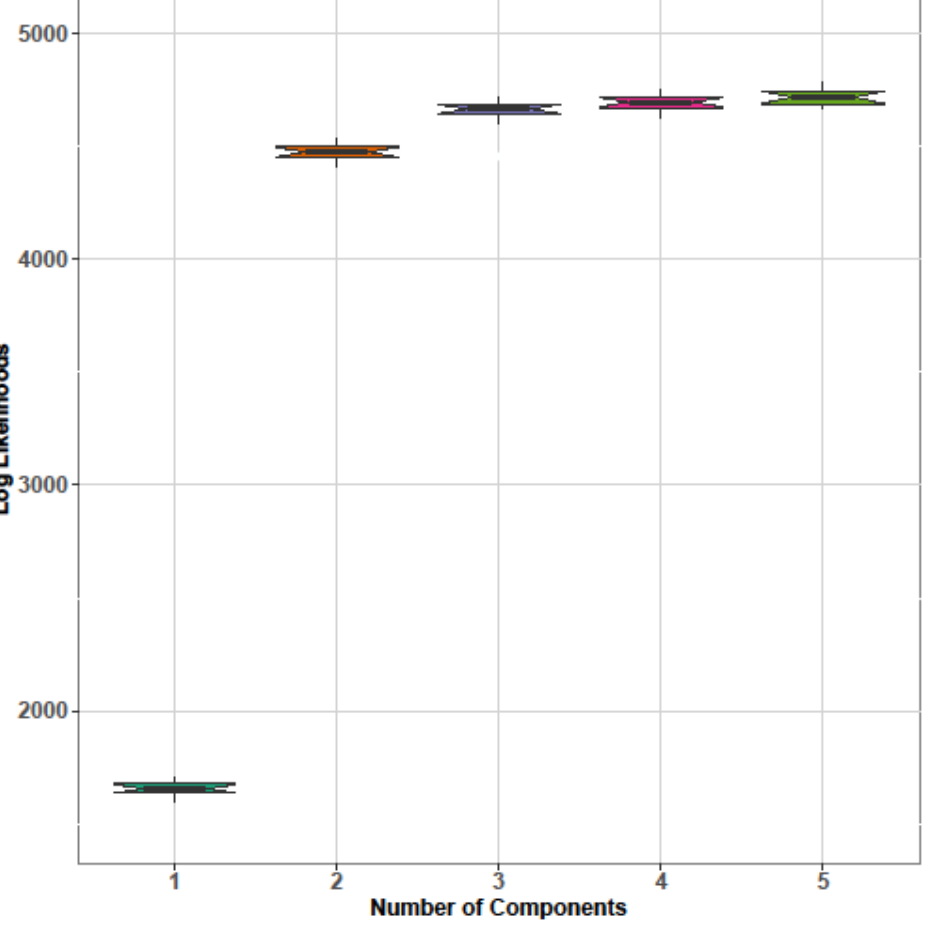
Figure 7. Log likelihood values for Gaussian mixture models with 1:5 components.